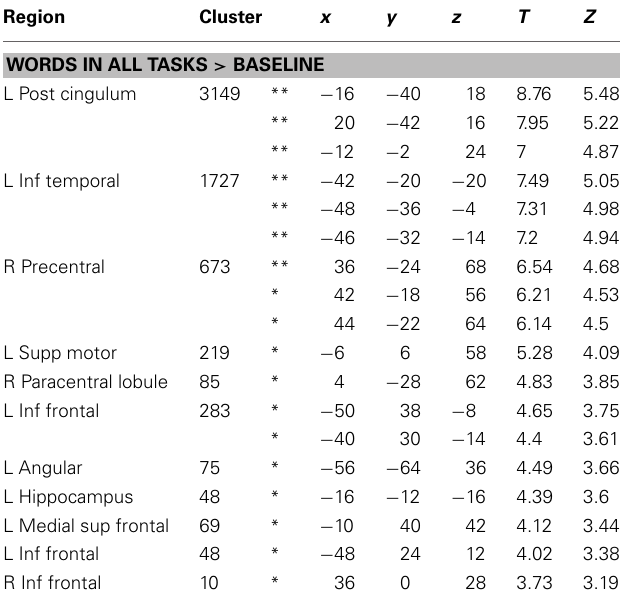
Table 2 | BOLD responses to words across tasks, at least p < 0 . 001